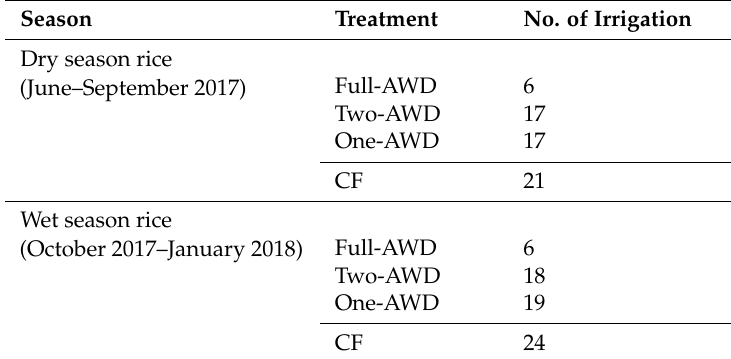
Table 1. Irrigation during the rice growing period under different irrigation